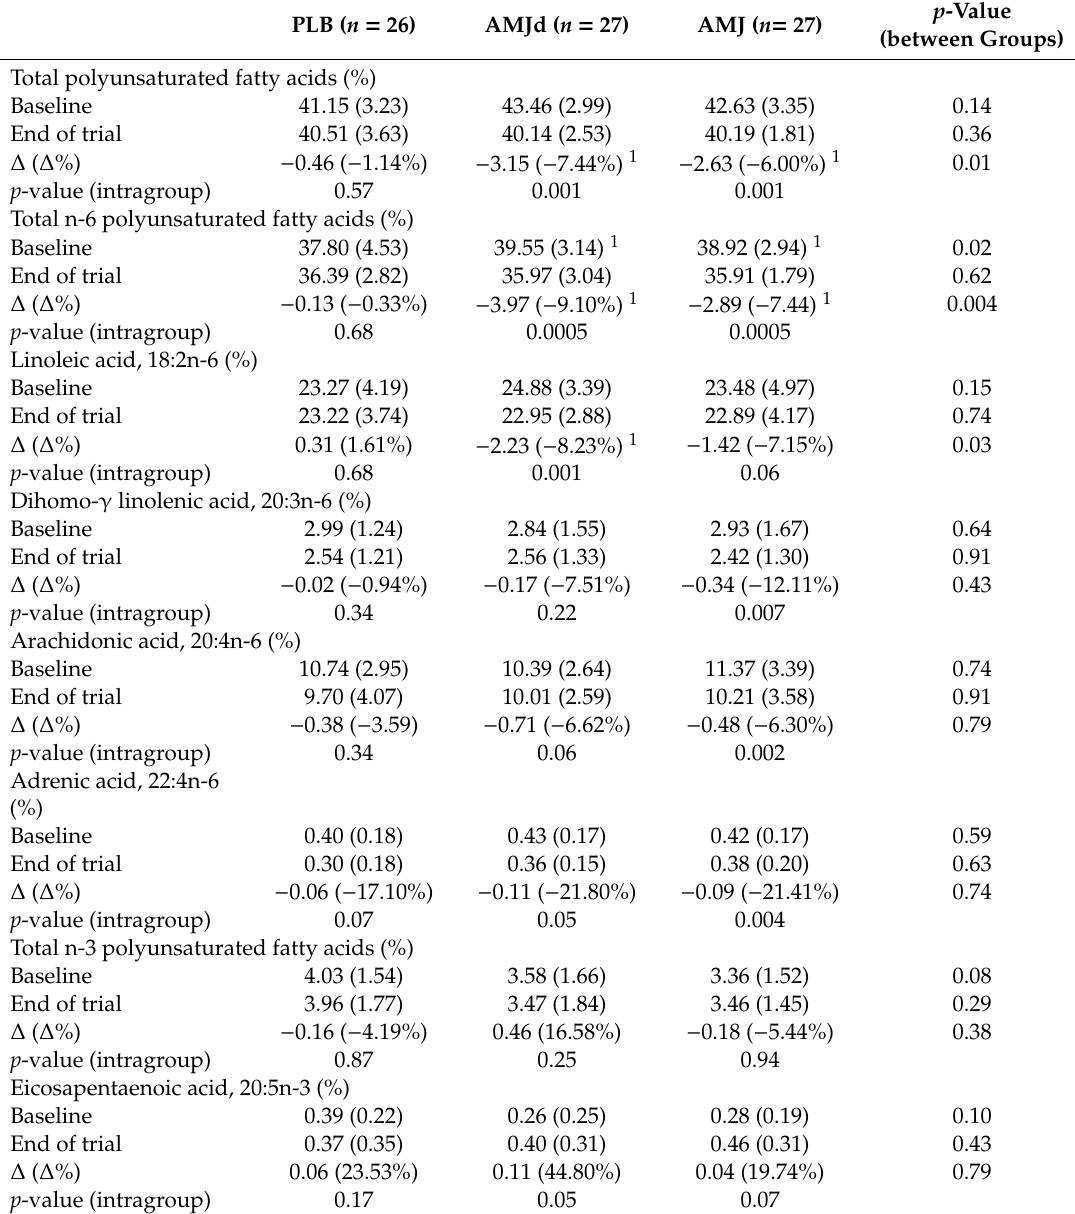
Table 4. Changes in the levels of polyunsaturated fatty acids (PUFAs) following daily intervention for four weeks with the placebo (PLB) drink, the polyphenol low-dose chokeberry juice (AMJd), and the polyphenol high-dose chokeberry juice